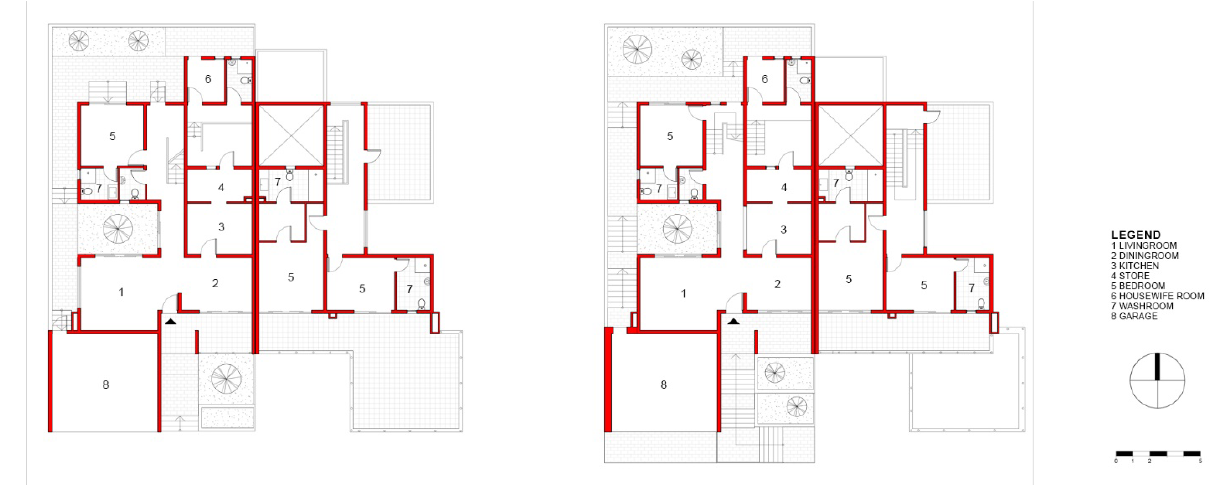
Figure 56. The Umudugudu Kigali Vision: Ground and first floor town houses. Drawing by Manlio